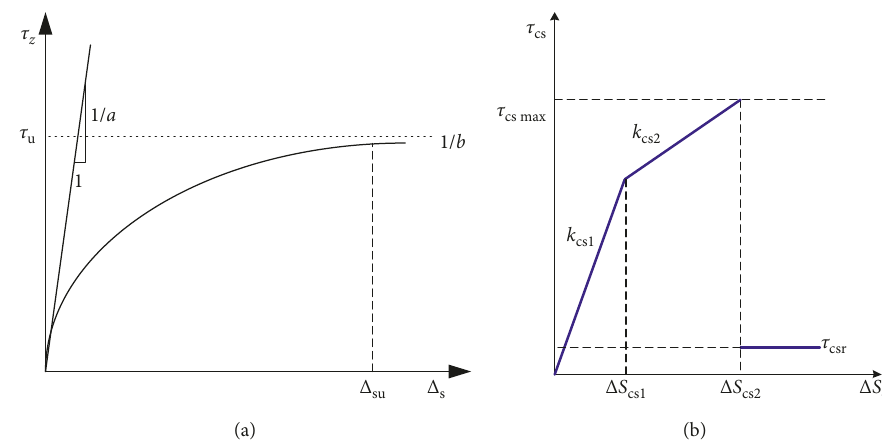
Figure 9: The relationship between shear stress and relative displacement of pile